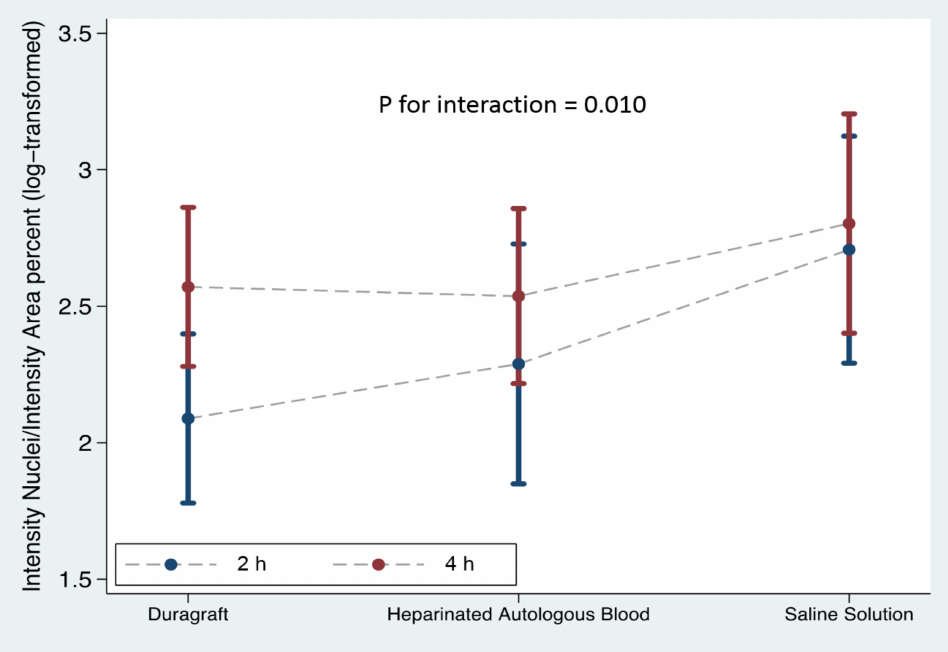
Figure 4. The comparison between the three different storage solutions at the two time sets: the blue line represents the preservation of the vein graft at 2 h from vein harvesting; the red line indicates the preservation of the vein graft at 4 h from vein harvesting. Intensity nuclei/intensity area (percent) was log transformed for model